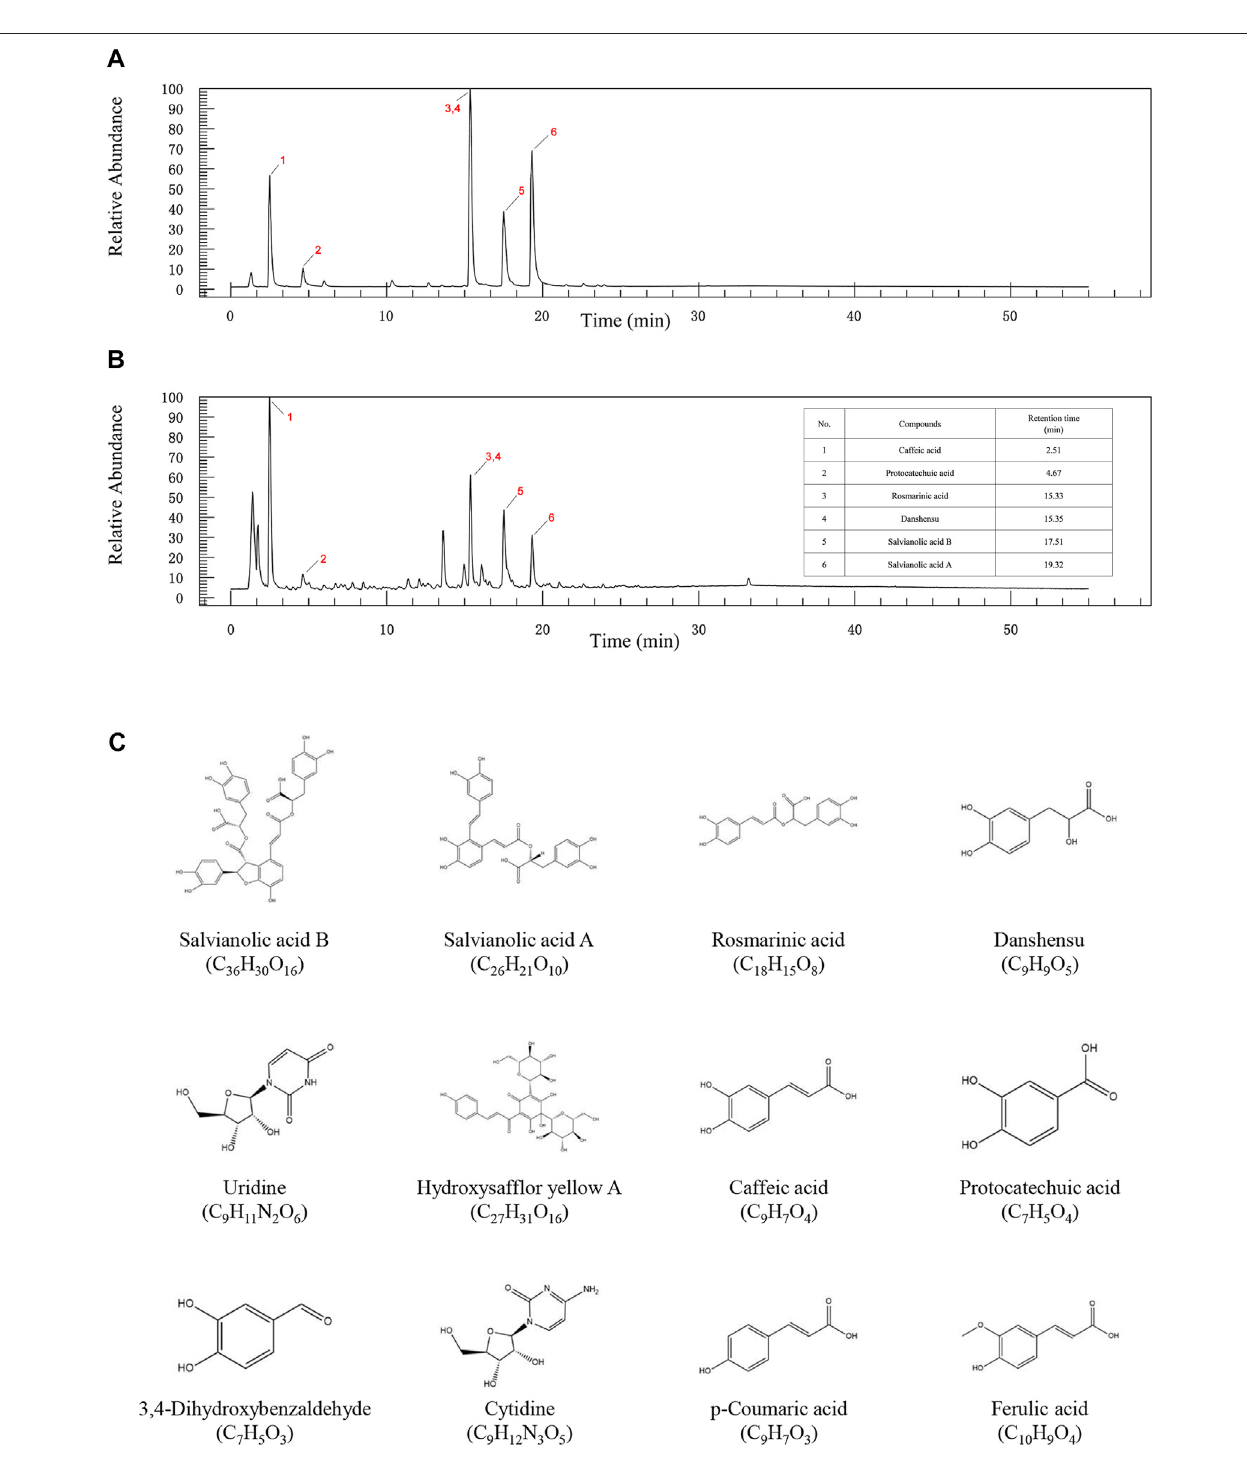
FIGURE 2 | The UPLC-QE-Orbitrap-MS chromatography of standard substances (A) and DHI (B) . (C) 2D structure diagram of key compounds.